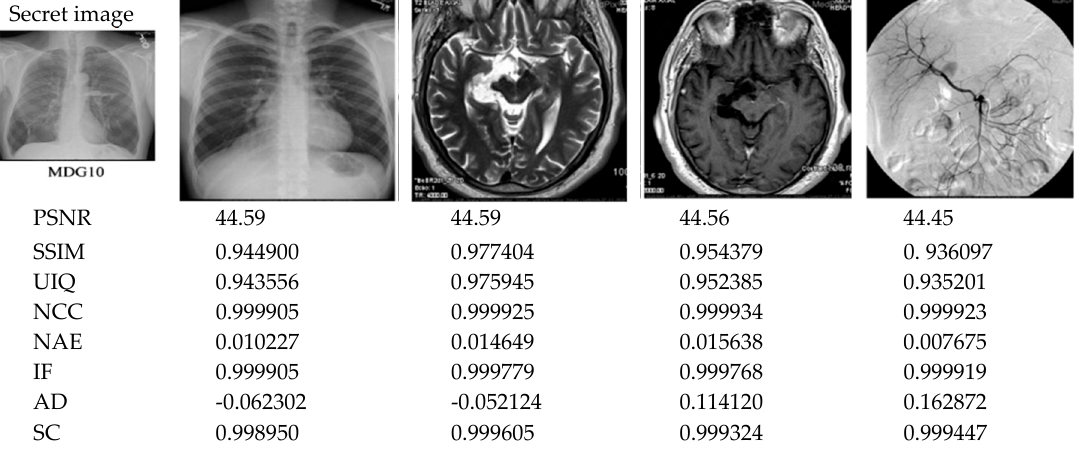
Figure 12. Performance analysis results of the proposed protocol. Here, the secret medical image MDG10 is embedded onto the remaining cover greyscale images shown (labelled MDG06 through MDG09 in Figure 3).